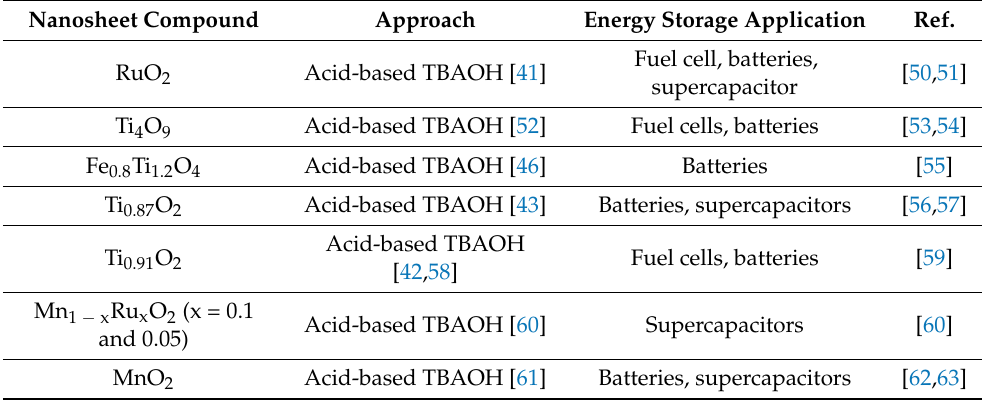
Table 1. TBAOH-based nanosheets and their applications in energy storage devices.